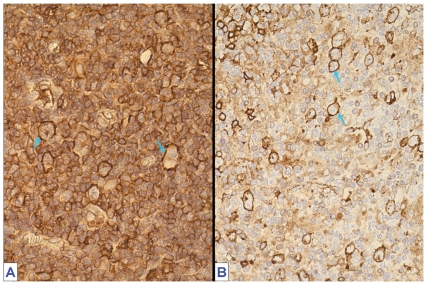
Immunohistochemical detection of Human Leukocyte Antigen (HLA) expression on formalin-fixed paraffin-embedded tissue sections of classical Hodgkin lymphoma (cHL).(A) HLA class I (using the HC-10 antibody) expression in cHL. All cells show immunoreactivity on the membrane. Hodgkin and Reed–Sternberg (HRS) cells stand out with their stronger signal (arrow) (original magnification 40×). (B) HLA class II (CR3/43) expression in cHL. Most HRS cells are positive (arrow), surrounded by negative inflammatory cells (original magnification ×40).